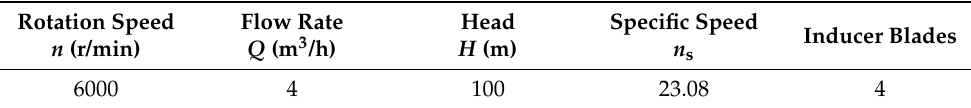
Table 1. The design